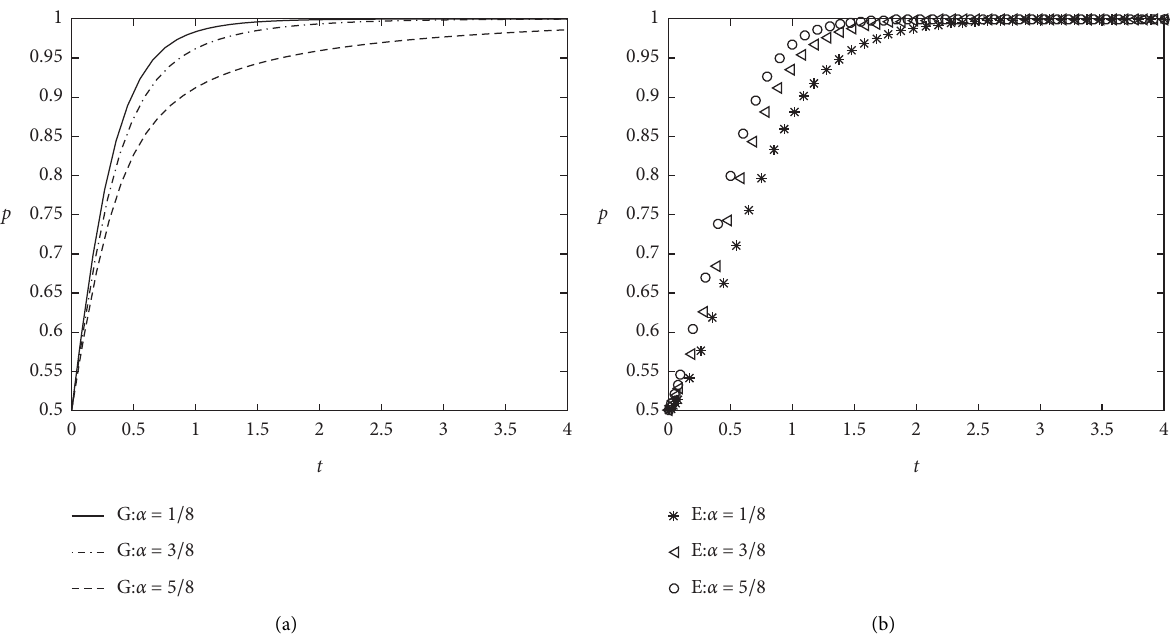
Figure 7: The impact of subsidy coefficient. Evolutionary behavior of (a) the local government and (b)